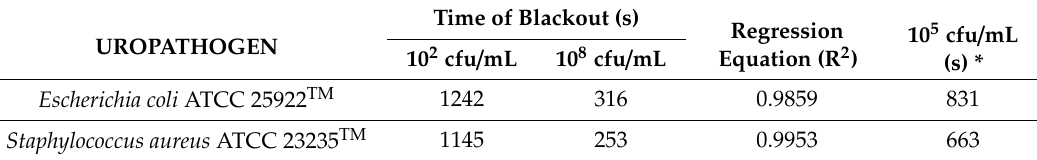
Figure 1. Relationship of blackout time and approximate log 10 cell density / mL of the four common uropathogens, which included Escherichia coli ATCC 25922 TM , Staphylococcus aureus ATCC 23235 TM , Proteus mirabilis ATCC 35659 TM , and Candida albicans ATCC 14053 TM in artificial urine. Table 1. Time of blackout for the four standard strains of